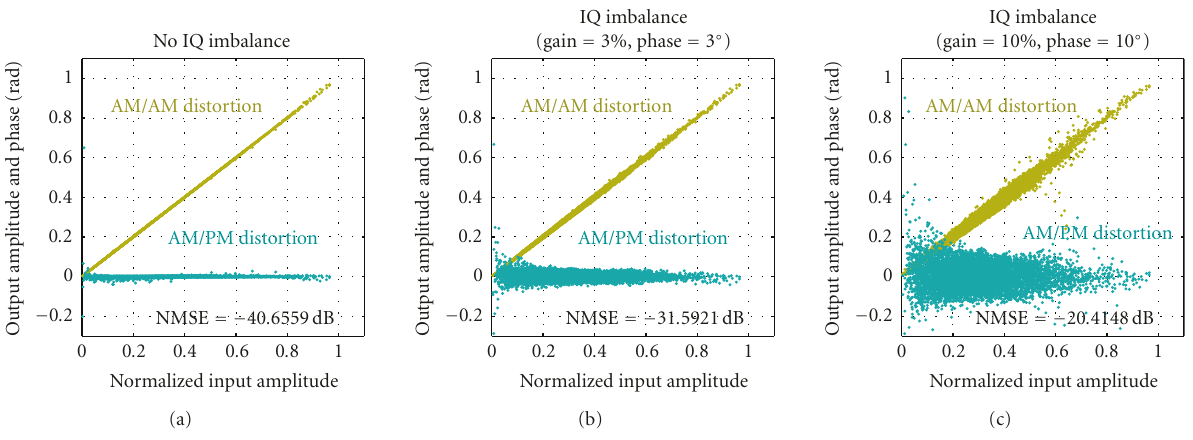
Figure 5: The AM/AM and AM/PM curves of the linearized PA with and without IQ imbalance.